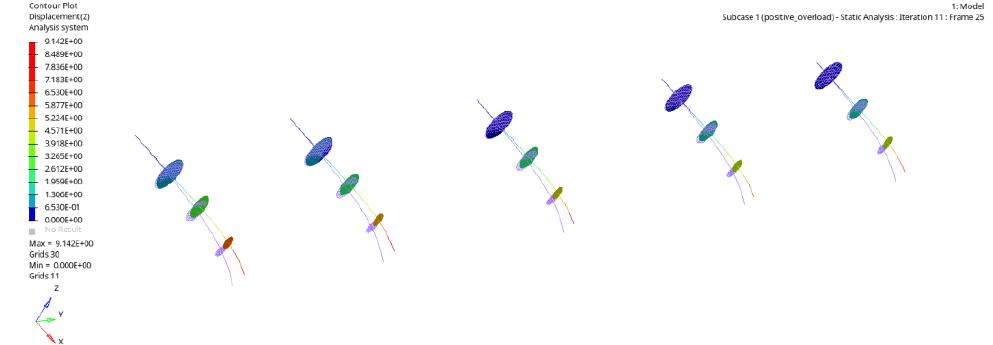
Figure 23. Z-direction displacement of curved beam and planar disk (condition D).